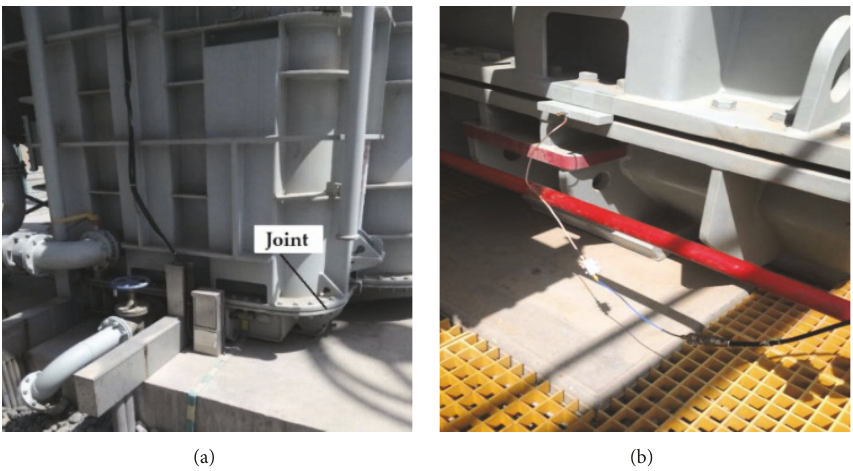
Figure 1: Joint between the barrel and base of a 750 kV